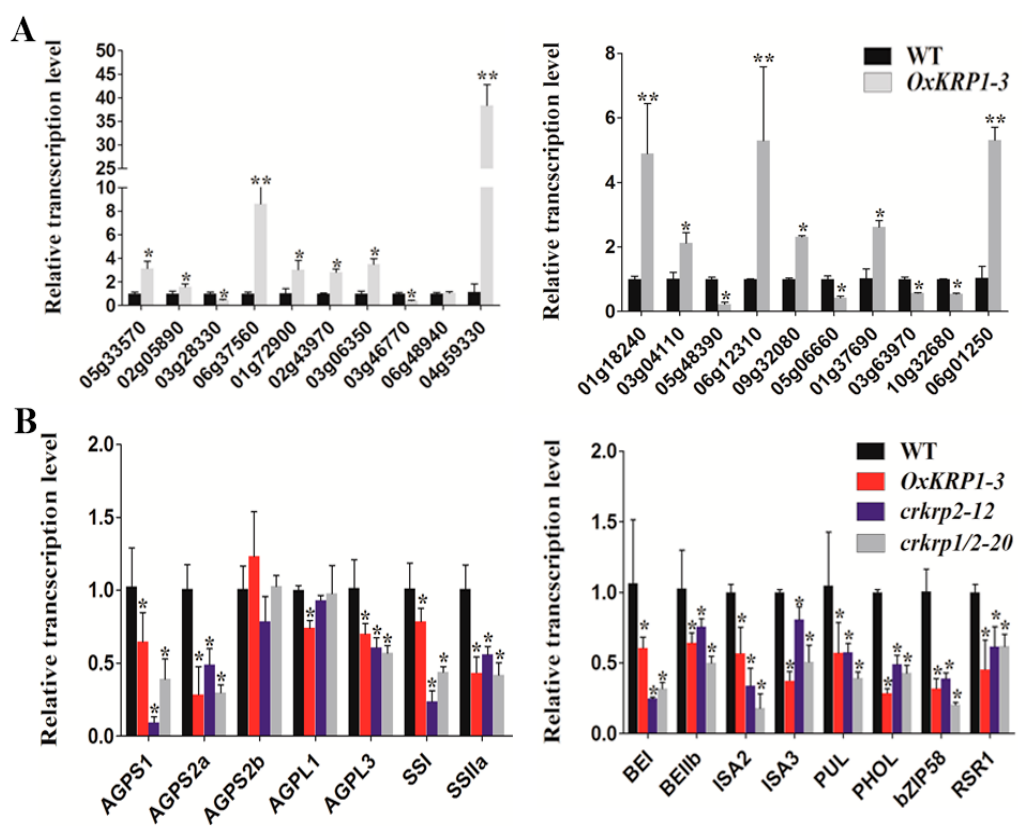
Figure 4. Expression analysis of KPR1 regulated genes by qRT-PCR. ( A ) qRT-PCR validation of the DEGs revealed by RNA-seq experiments; ( B ) qRT-PCR analysis of the transcriptional abundances of grain filling related genes in the WT, OxKRP1 , crkrp2 , and crkrp1/2 mutants. 6 DAP seed cDNA were used as templates for this analysis. DEGs: Differentially Expressed Genes. Error bars indicate SD with biological triplicates ( n = 3). Asterisks indicate the significant difference between the WT and transgenic lines, as determined by Student’s t -test analysis: * p < 0.05, ** p < 0.01. Primers used in ( A ) were listed in Table S1. Primers used in ( B ) were used according to previous reports [22,23].